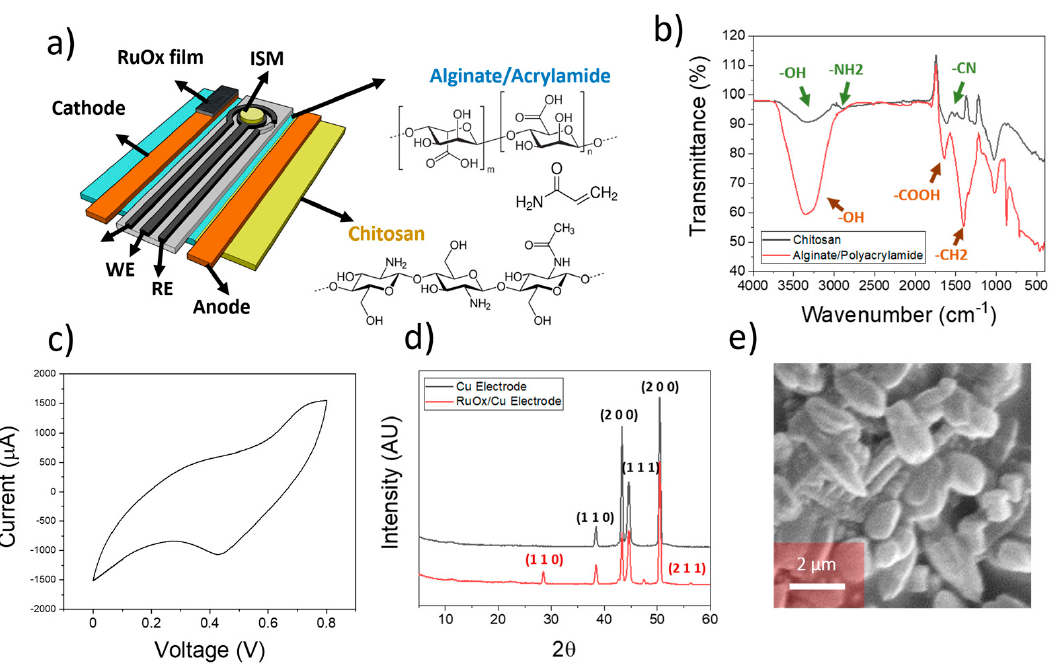
Figure 1. ( a ) Schematical representation of the device employed for the reversed iontophoresis experiments. The sensors included an ion-selective membrane within a three-electrode cell, and two different electrodes were incorporated for the ion extraction process. The different elements of the electrodes are indicated. ( b ) FTIR spectra of the hydrogels used within the anode (chitosan) and cathode (Alginate/Polyacrylamide) elements. ( c ) Cyclic voltammogram obtained during the electrodeposition of ruthenium oxide onto copper electrodes. ( d ) XRD plot of both copper electrode and RuO x -modified copper electrode used for the ion extraction process. The corresponding crystal planes from each element are indicated. ( e ) SEM imaging of electrodeposited RuO x onto copper